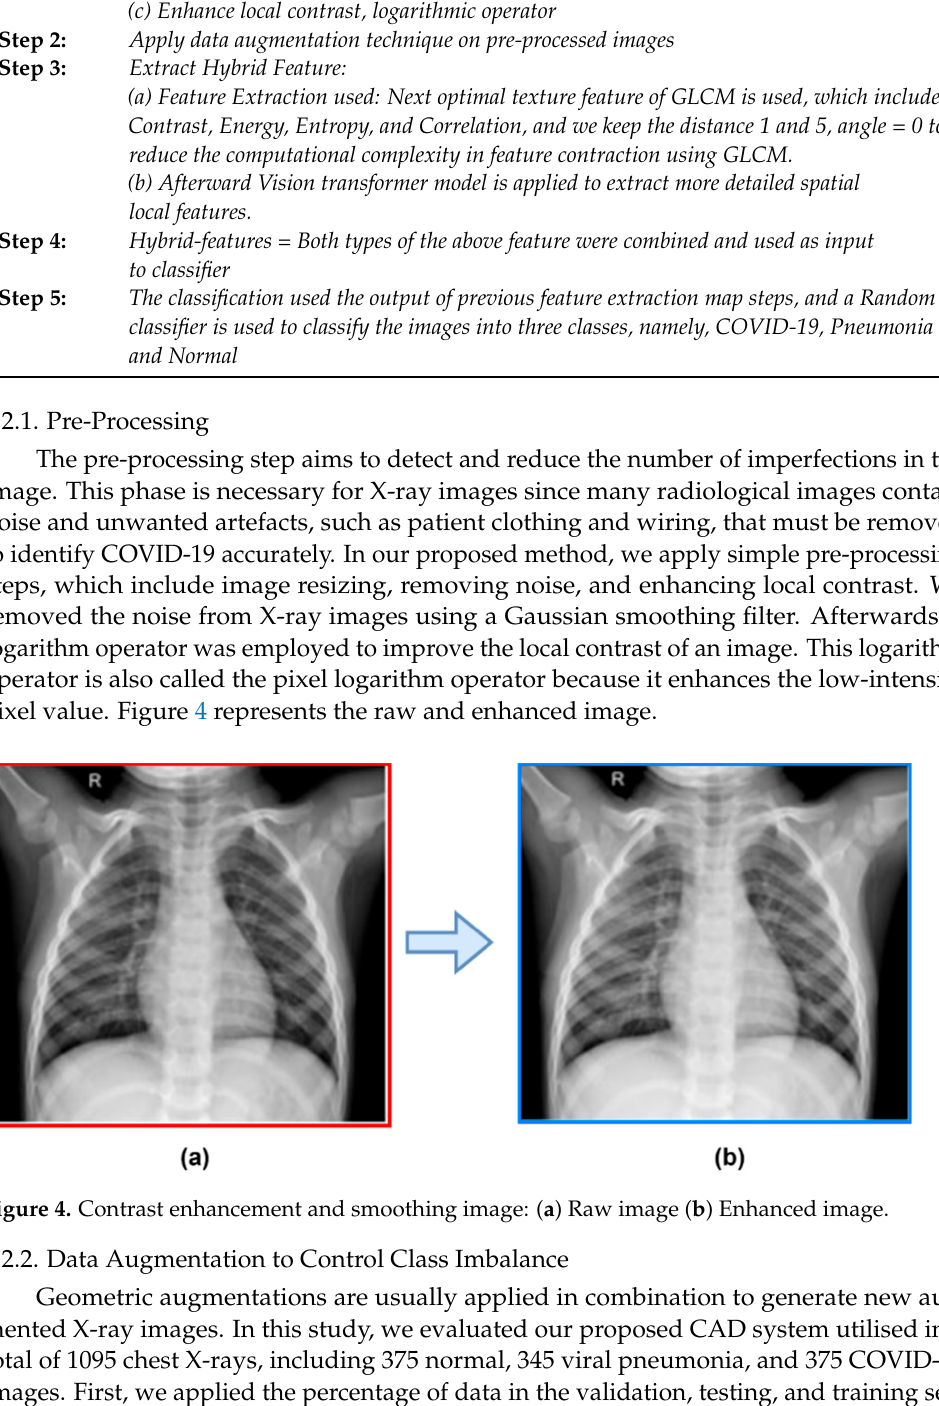
Algorithm 1: Classification of chest disease by using hybrid features and random forest classifier